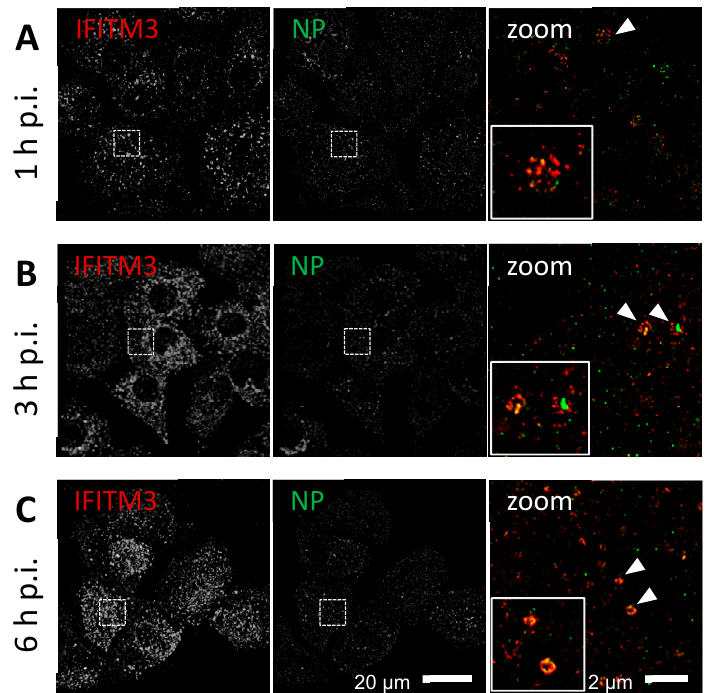
Figure 4. IFITM3 co-localization with influenza A virus (IAV) nucleoprotein (NP) in primary human cells. The indirect immunofluorescence analysis of human small airway epithelial cells (HSAEpCs) infected with IAV A / Puerto Rico / 8 / 1934 (MOI = 10) using anti-IFITM3 (red) in combination with anti-NP (green). ( A ) 1 h p.i., ( B ) 3 h p.i., and ( C ) 6 h p.i. The images show extra-nuclear regions of HSAEpCs. The image acquisition was performed using a 60 nm ( = confocal mode, overview) and 20 nm ( = STED, merged zoom) pixel size. The dashed square indicates the zoom-in area. White arrow heads indicating ring-like structures with IFITM3 clustering.